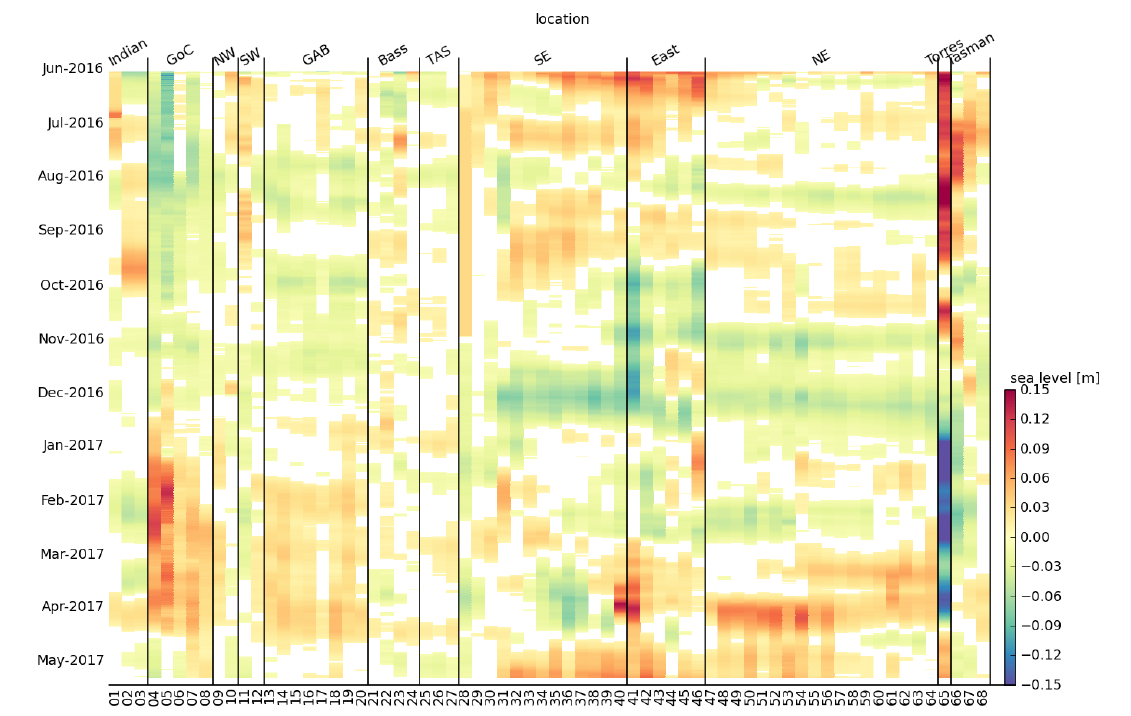
Figure 11. Temporal signal from bias correction histories after subtraction of respective mean offsets. Absolute values less than 0.01 m are shown as white. A degree of coherence is apparent between adjacent sites within the regional groupings-shown on map in Figure